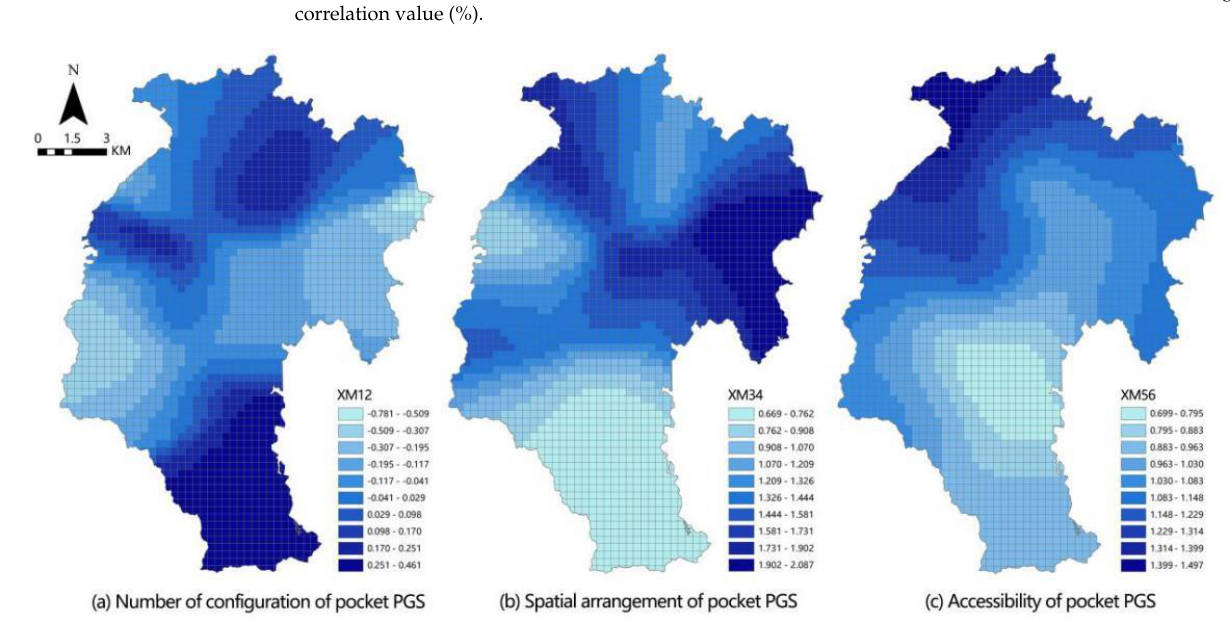
Table 10. Spatial correlation results between 3-scale PGS and coupling coordination degree (CCD).